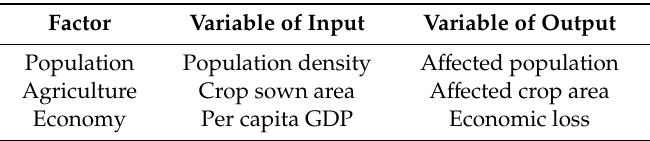
Table 1. Selection of